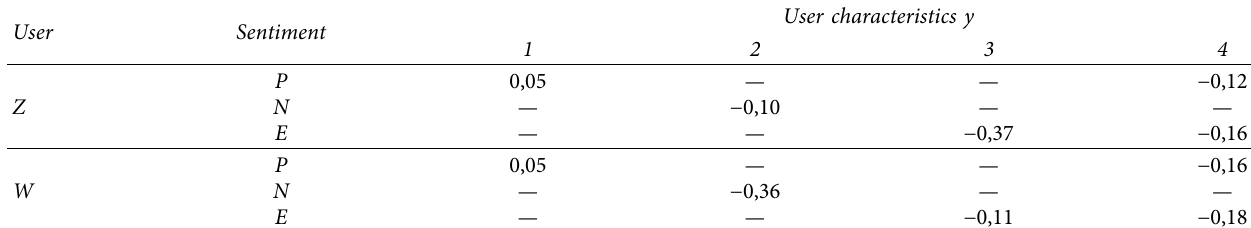
Table 2: Elasticity evaluation adopting the posterior parameters in the numerical